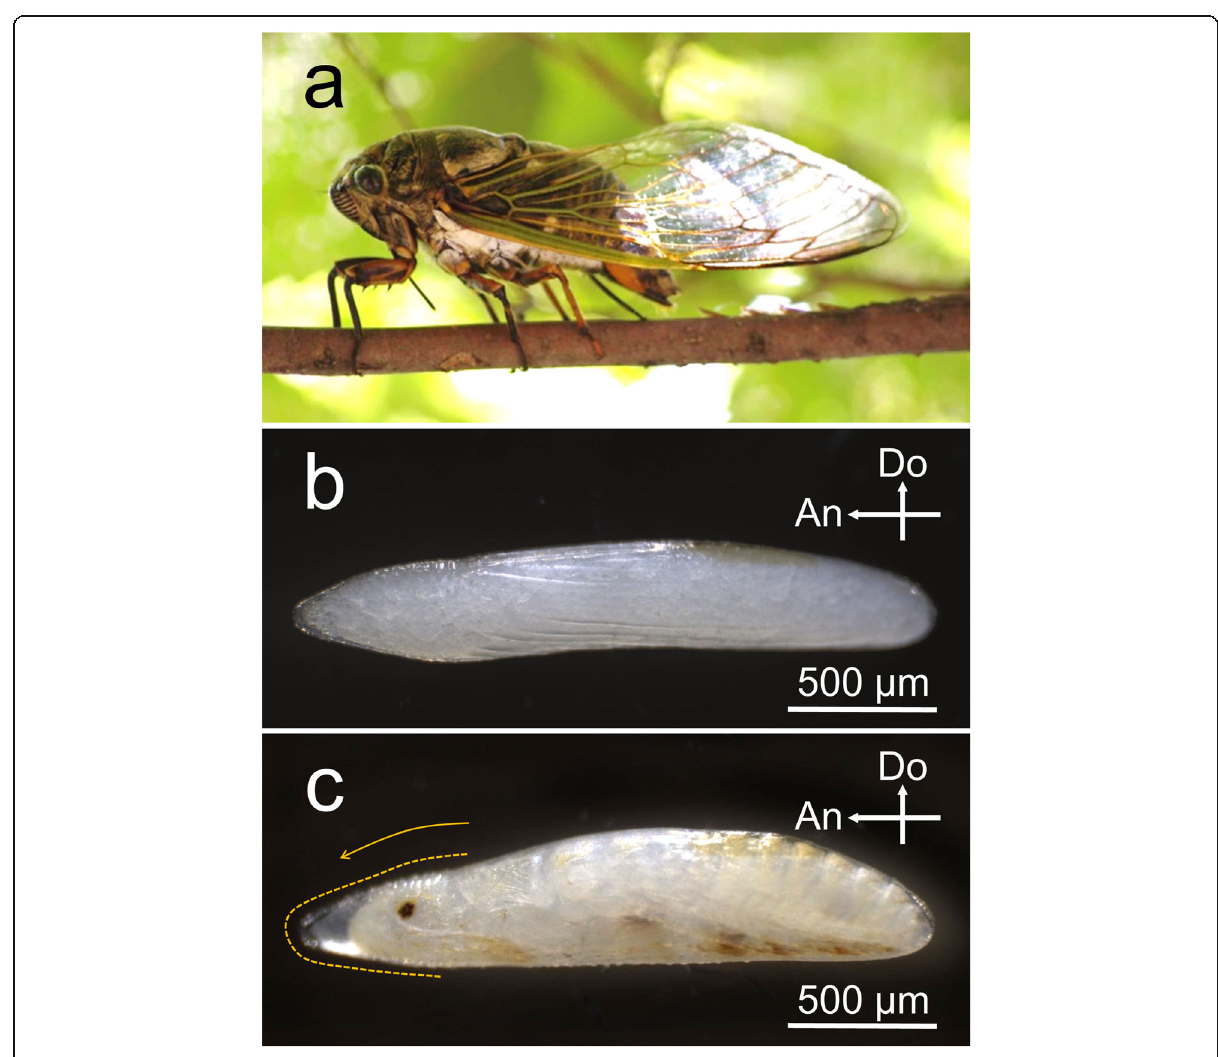
Fig. 1 Eggs of Cryptotympana facialis . a An adult female of C. facialis laying eggs in a dead twig. b An egg on the day of oviposition. c An egg with a fully developed embryo. An orange broken line indicates the site of eggshell cleavage (hatching line), and an orange arrow indicates the cleavage direction. Crossed arrows indicate the anterior (An) and dorsal (Do)